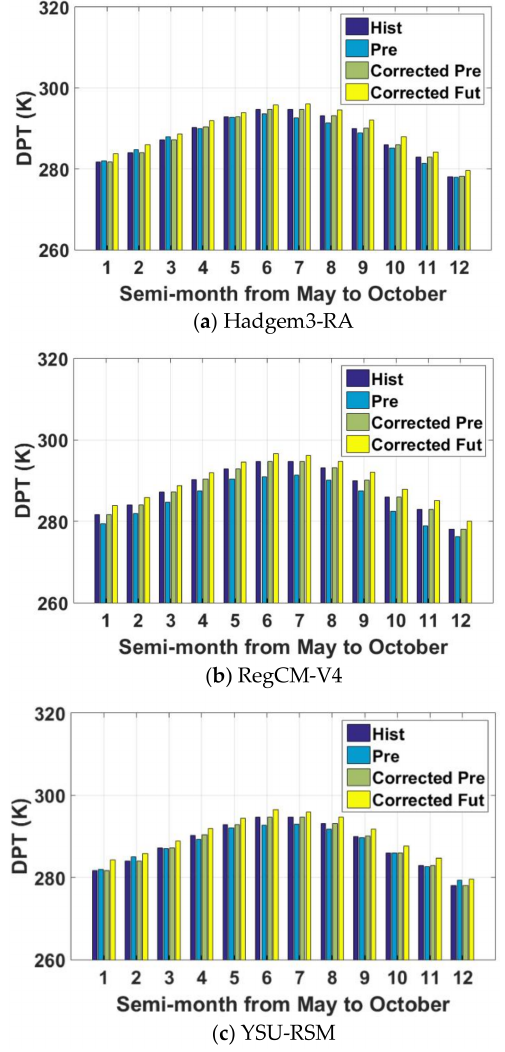
Figure 3. Bias-correction of daily dew-point temperature driven by CORDEX RCMs (Seoul